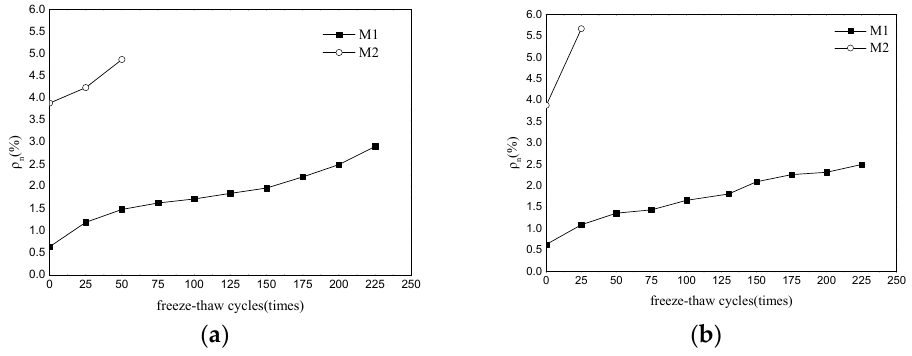
Figure 5. Water absorption changes in MKPC mortar samples and P.O mortar samples under freezing and thawing conditions. ( a ) water freeze-thaw; ( b ) 5% Na 2 SO 4 freeze-thaw.